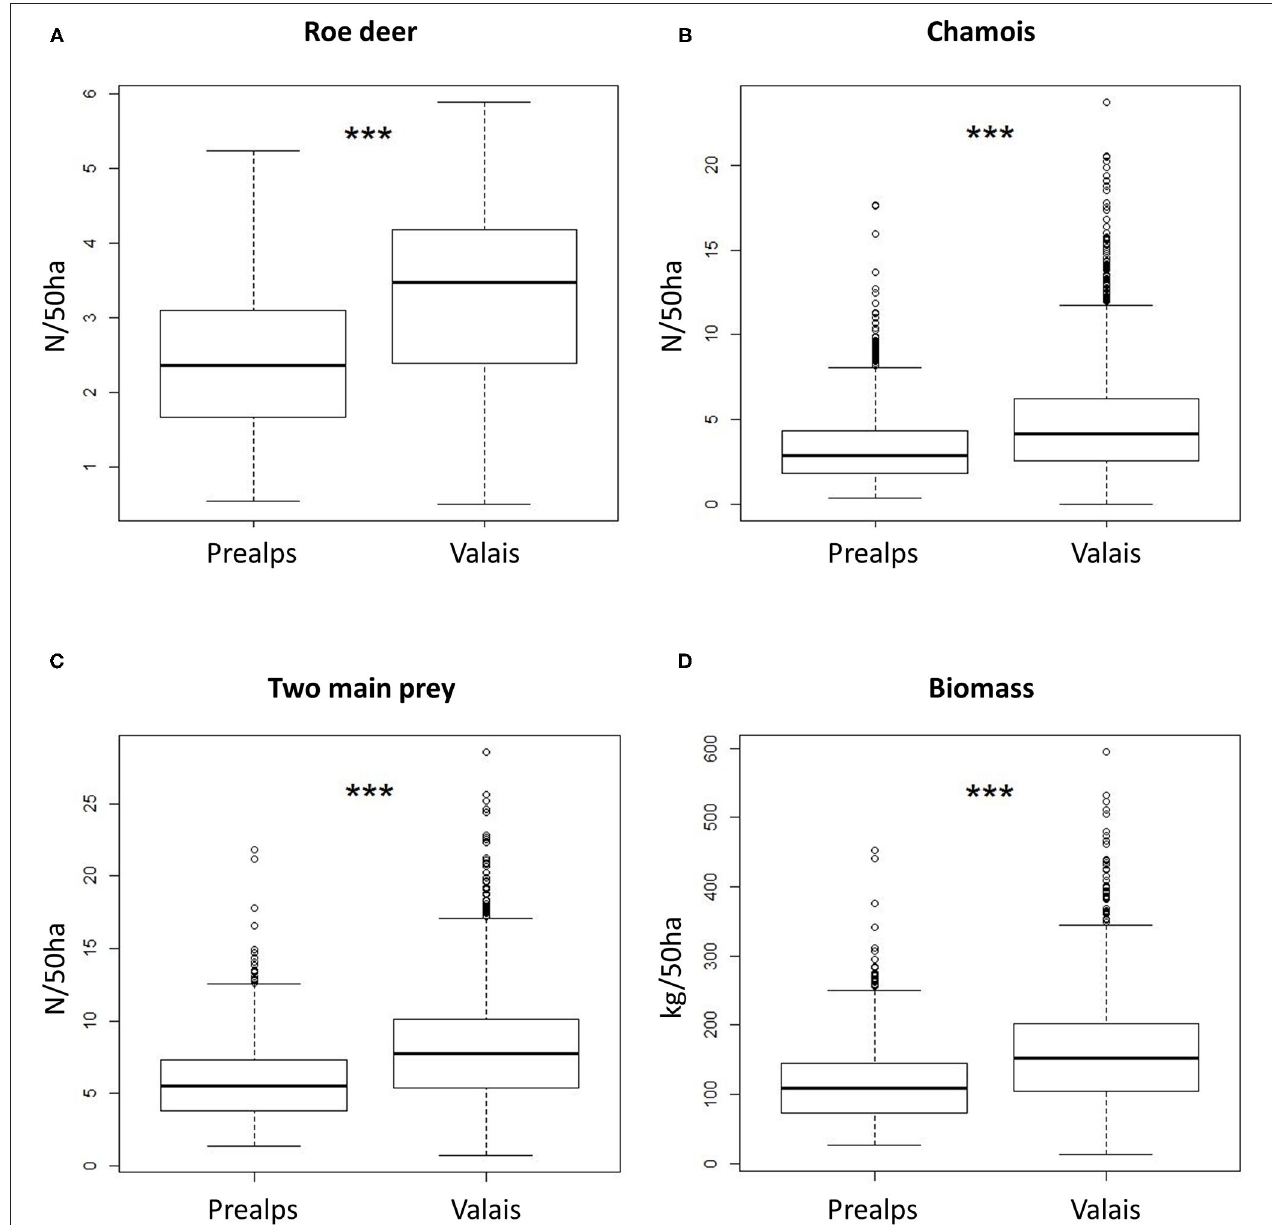
FIGURE 5 | Statistical comparison of wild ungulate relative densities and biomass between the northwestern Prealps and Valais: (A) roe deer density; (B) chamois density; (C) density of these two main prey species grouped and (D) their biomass in number of individuals and kg per 50 ha, respectively. *** P < 0.001 (Wilcoxon test).